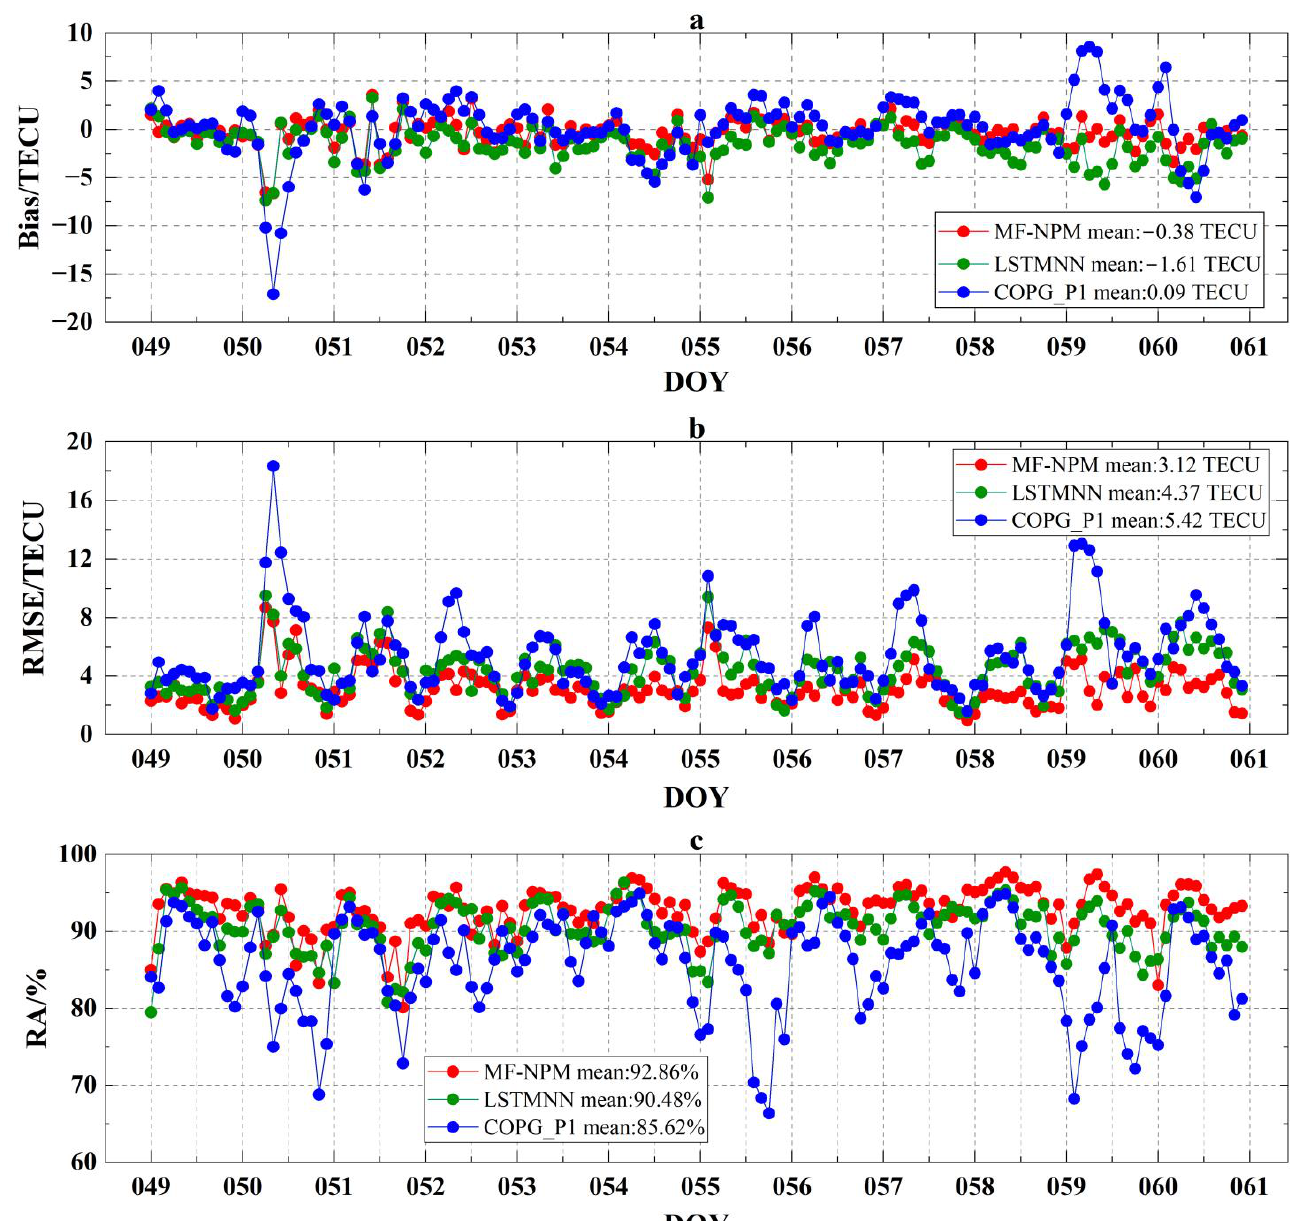
Figure 9. The variations of ( a ) bias, ( b ) RMSE, and ( c ) relative accuracy of MF-NPM, LSTMNN, and COPG_P1, with respect to IGS during geomagnetic storms (DOY 049~060 in 2014).